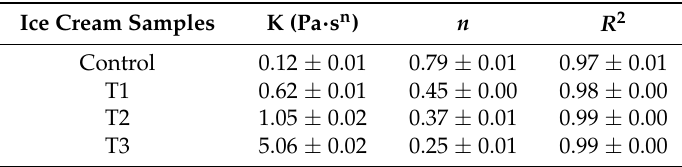
Figure 2. Rheological curves of different ice cream mixes. Table 2. The values of rheological parameters of ice cream